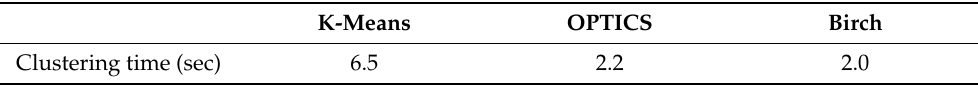
Table 1. Comparison of clustering efficiency results.